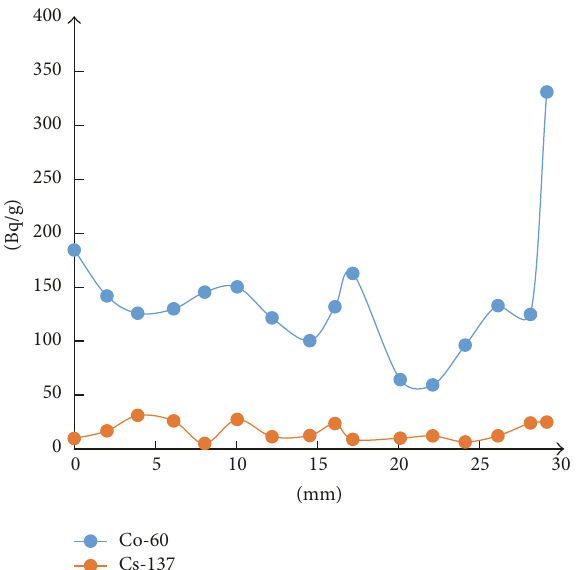
Figure 8: Distribution profiles of Co-60 and Cs-137 activities at different spherical radii in the selected graphite sphere.